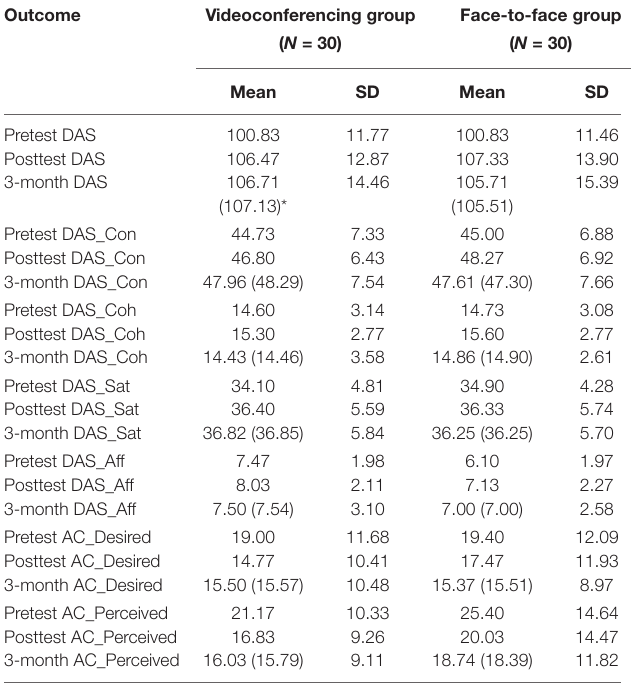
TABLE 1 | Means (adjusted means) and standard deviations for the dyadic adjustment scale and subscales, and the areas of change questionnaire subscales in the videoconferencing and control conditions ( N =